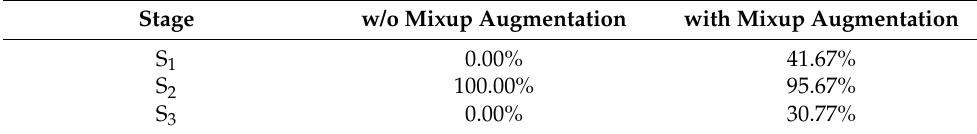
Table 2. Compare the CNN trained with or without mix-up augmentation in the female.